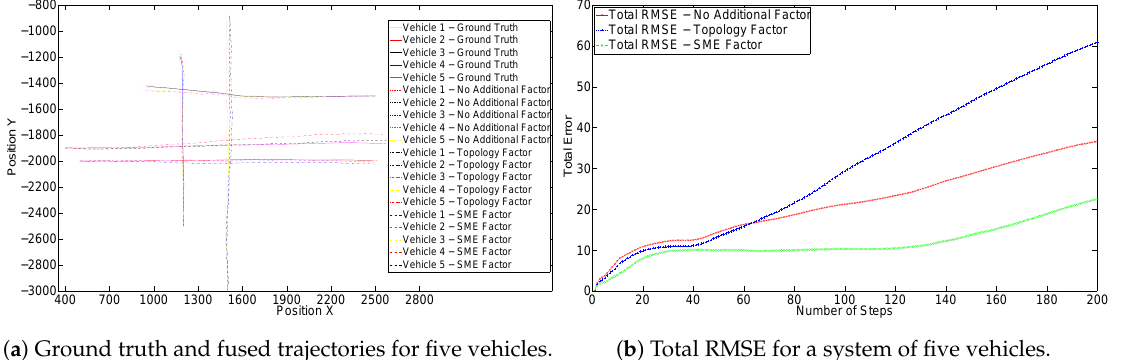
( b ) Total RMSE for a system of five vehicles. Figure 8. Third set without GPS for the simulated trajectories of five vehicles at an intersection.